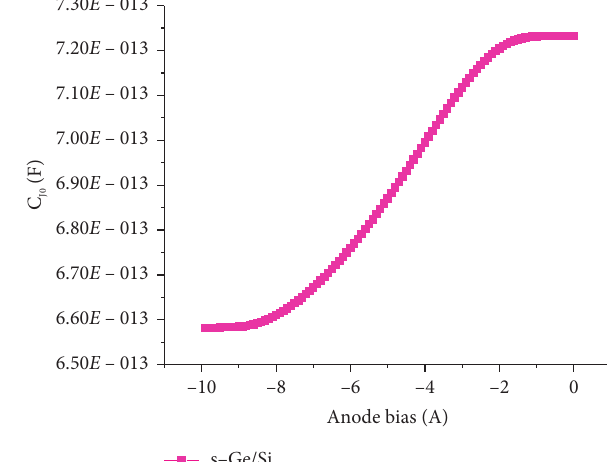
Figure 9: s-Ge/Si Schottky diode C-V curve.